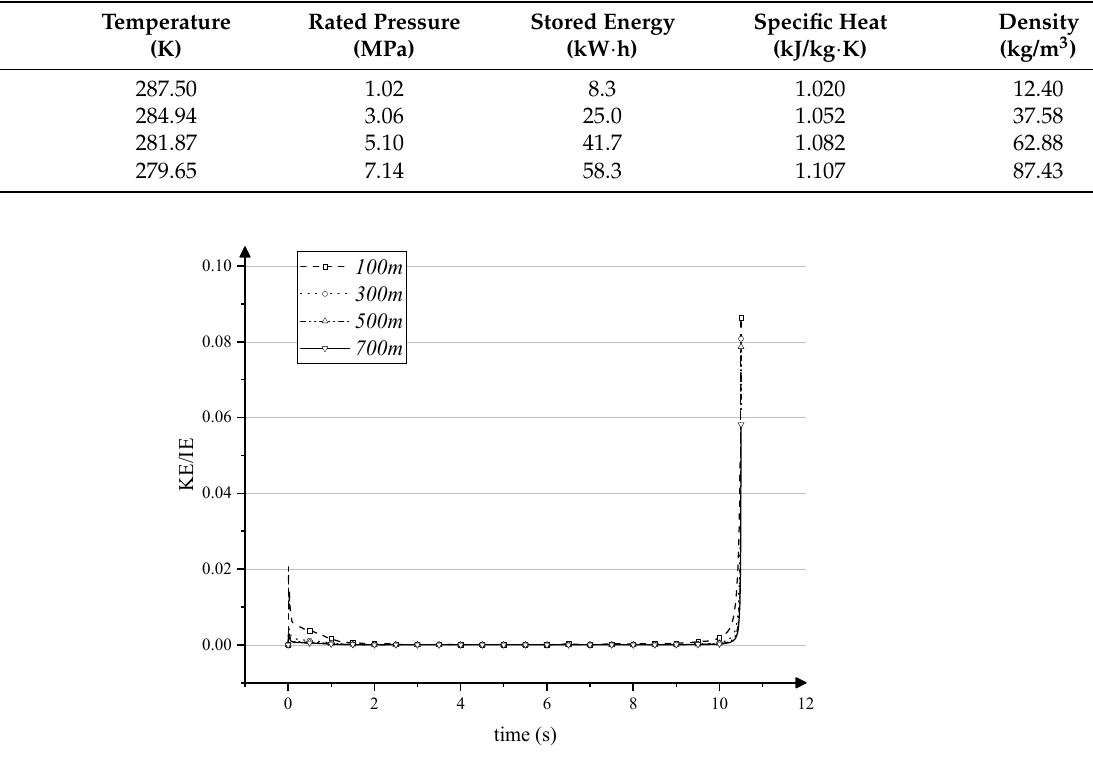
Figure 12. History curves of the KE/IE ratio in the scenarios of the 4 m airbag at different depths.